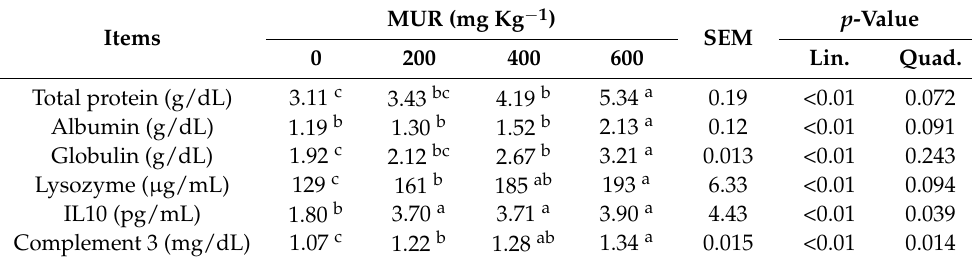
Table 8. Effect of MUR on serum immune indices of broiler